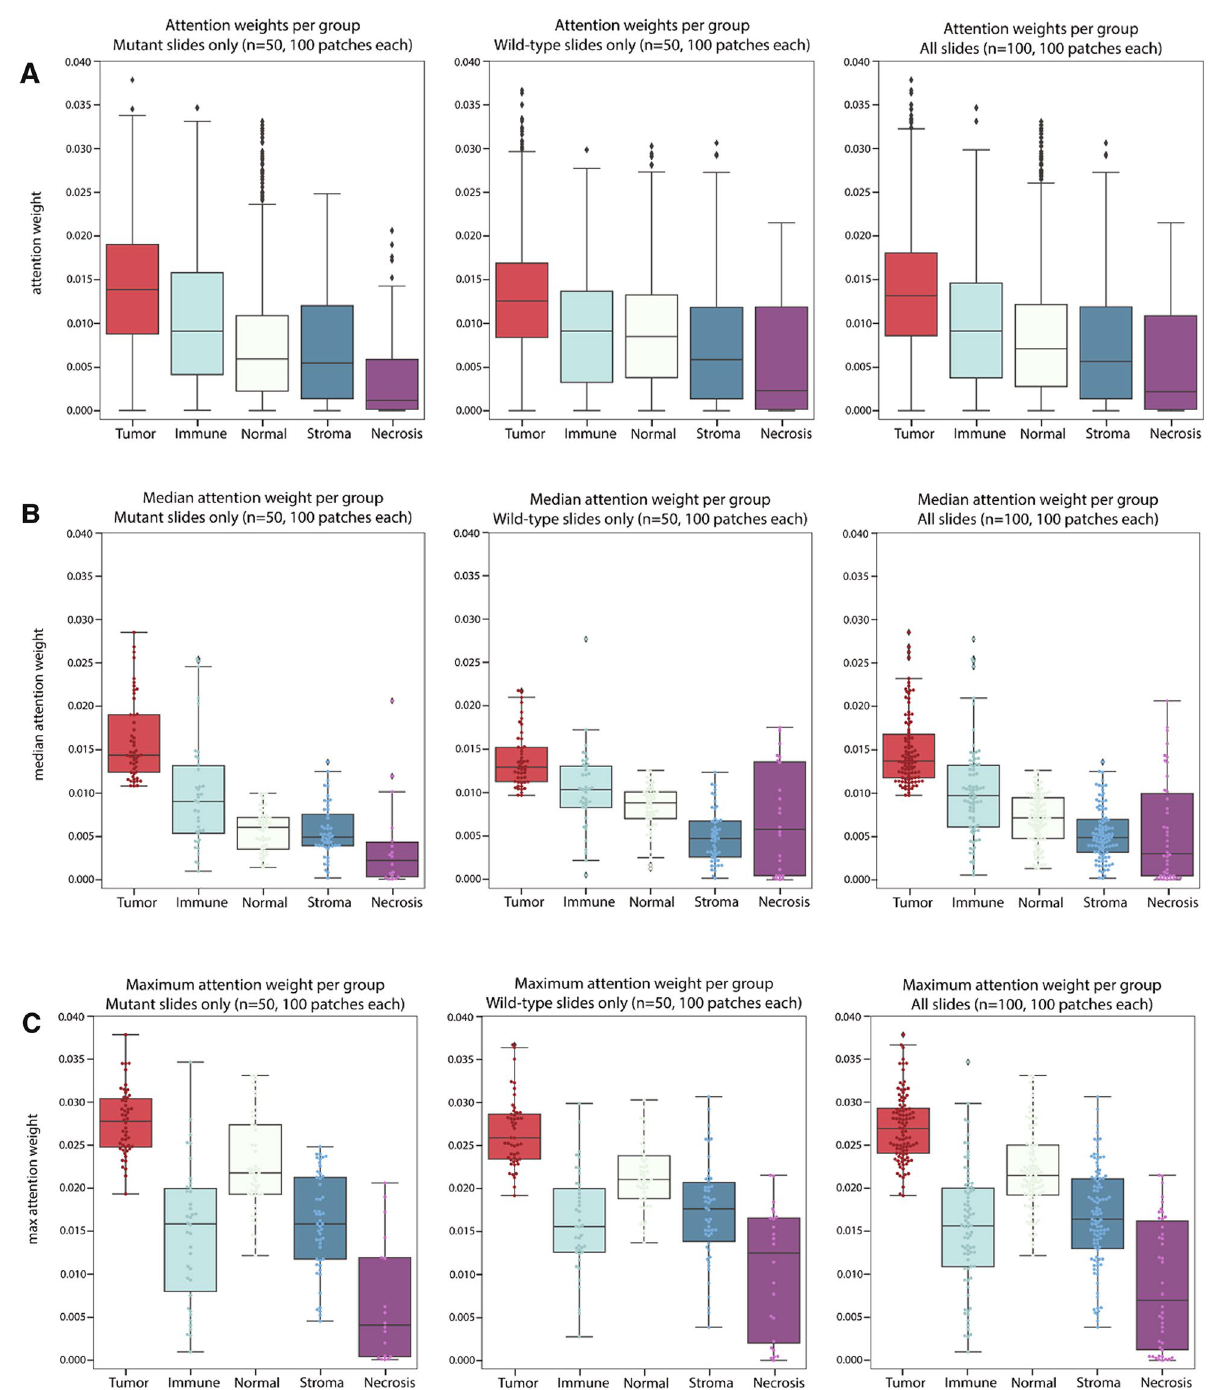
Figure 3. Bags from slides with high-confidence predictions assessed by the MIL model, with attention weights extracted for each patch within the bags. (a) All patch , (b) median per slide, and (c) maximum per slide attention weights for EGFR prediction as separated by predicted tissue morphology from (left column) 50 EGFR mutant slides, (center column) 50 EGFR wild-type slides, and (right column) 100 slides combined. (d) EGFR TP exemplar with attention weights from bag of 250 patches. The six highest attention patches are shown (I-VI). (e) EGFR TN exemplar with attention weights from bag of 250 patches. The six highest attention patches are shown